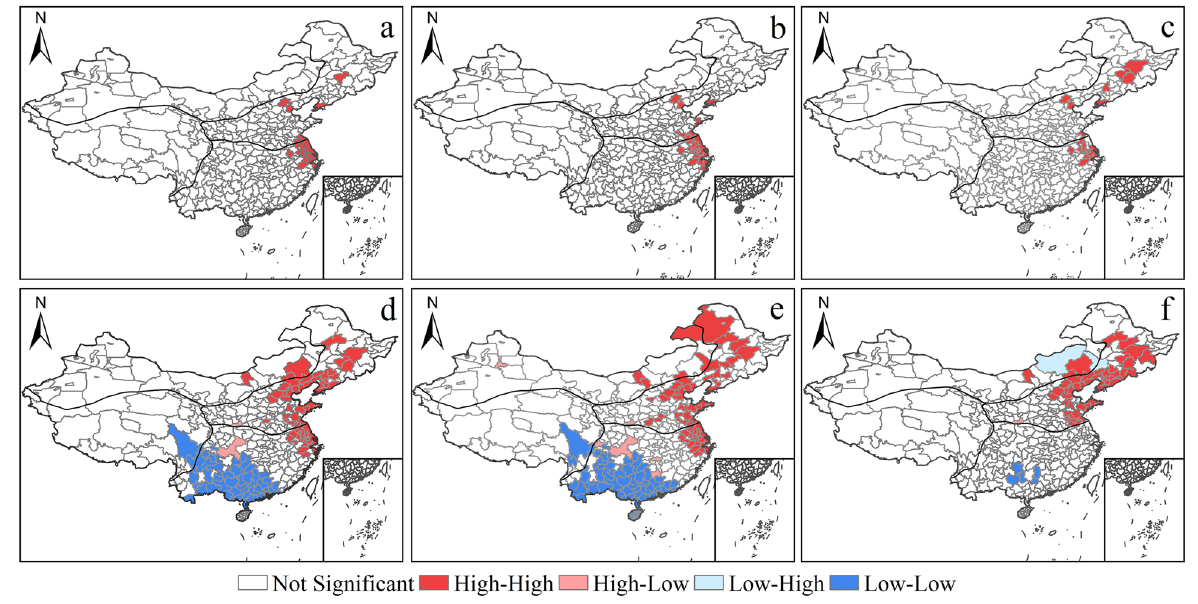
Fig. 4 Bath industry and its sub-categories LISA agglomeration